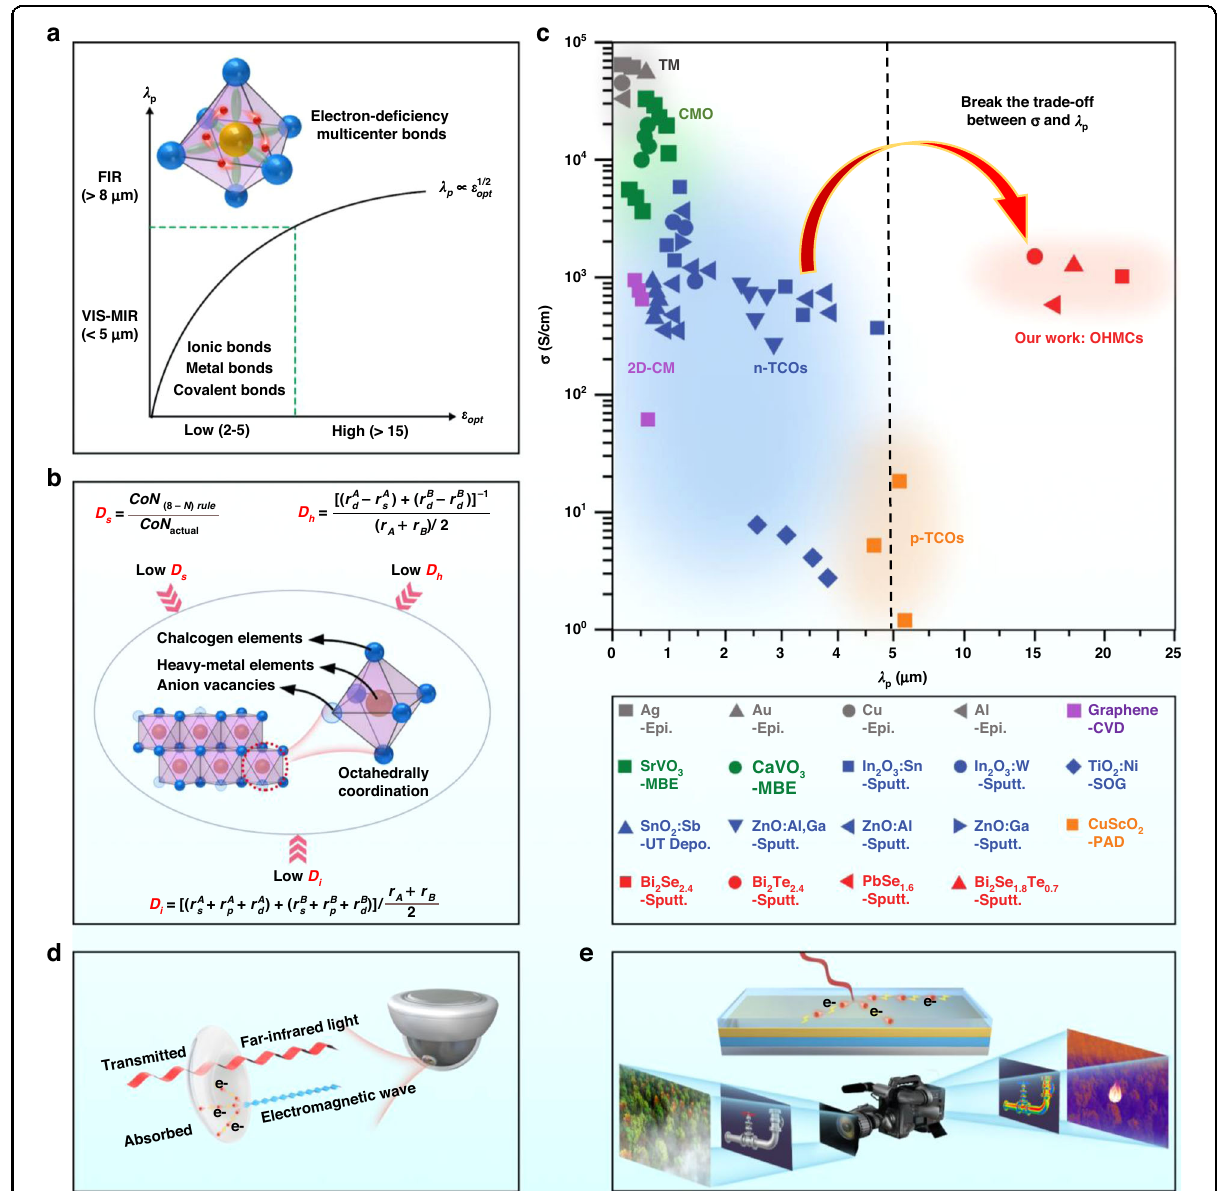
Fig. 1 Material design of far-infrared transparency and conductivity. a The positive correlation between λ p and ε opt . Typical materials with ionic, metal, and covalent bonds usually have smaller ε opt and λ p , while materials with electron-de fi ciency multicenter bonds have greater ε opt and λ p . b The three microscopic principles for the formation of the electron-de fi ciency multicenter bond, and the octahedrally-coordinated heavy-metal chalcogenides and their solid solutions selected by the three principles. The introduction of anion vacancies is to obtain shallow energy level defects and good conductivity. c The plasma absorption edge and room temperature conductivity of traditional transparent conductive materials and the four heavy-metal chalcogenides (red) that we prepared (Supplementary refs. 25 – 32), where gray, green, blue, orange, purple, and red represent thin metals (TM), correlated metal oxonates (CMO), n-type transparent conductive oxide (n-TCOs), p-type transparent conductive oxide (p-TCOs), 2D carbon materials (2D-CM), and octahedrally-coordinated heavy-metal chalcogenides (OHMCs), respectively. The materials and preparation methods are detailed in SI. The “ continuous fi lm ” type far-infrared electromagnetic shielder ( d ) and far-infrared photodetector ( e ) based on far-infrared transparent